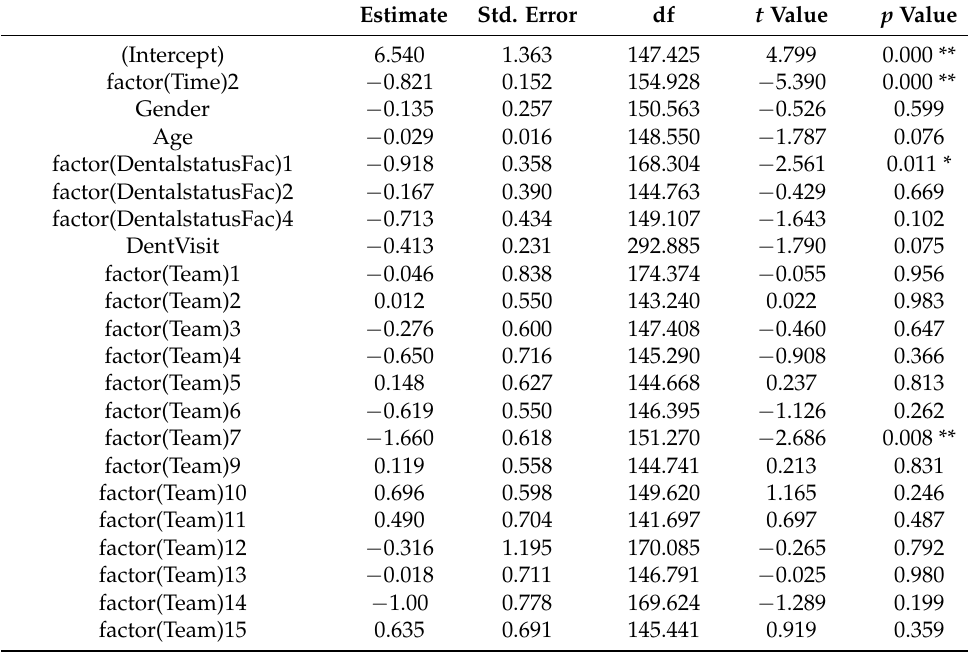
Table 4. Multilevel model of OHAT scores.